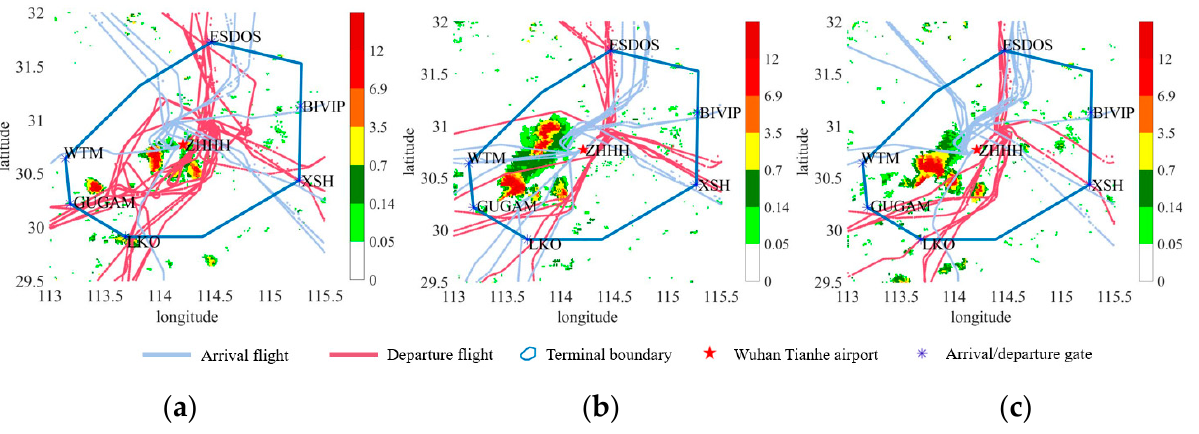
Figure 13. Overlay graph of flight radar trajectories with weather information for Wuhan terminal area. ( a )12:00–13:00 (BST); ( b ) 13:00–14:00 (BST); ( c ) 14:00–15:00 (BST).